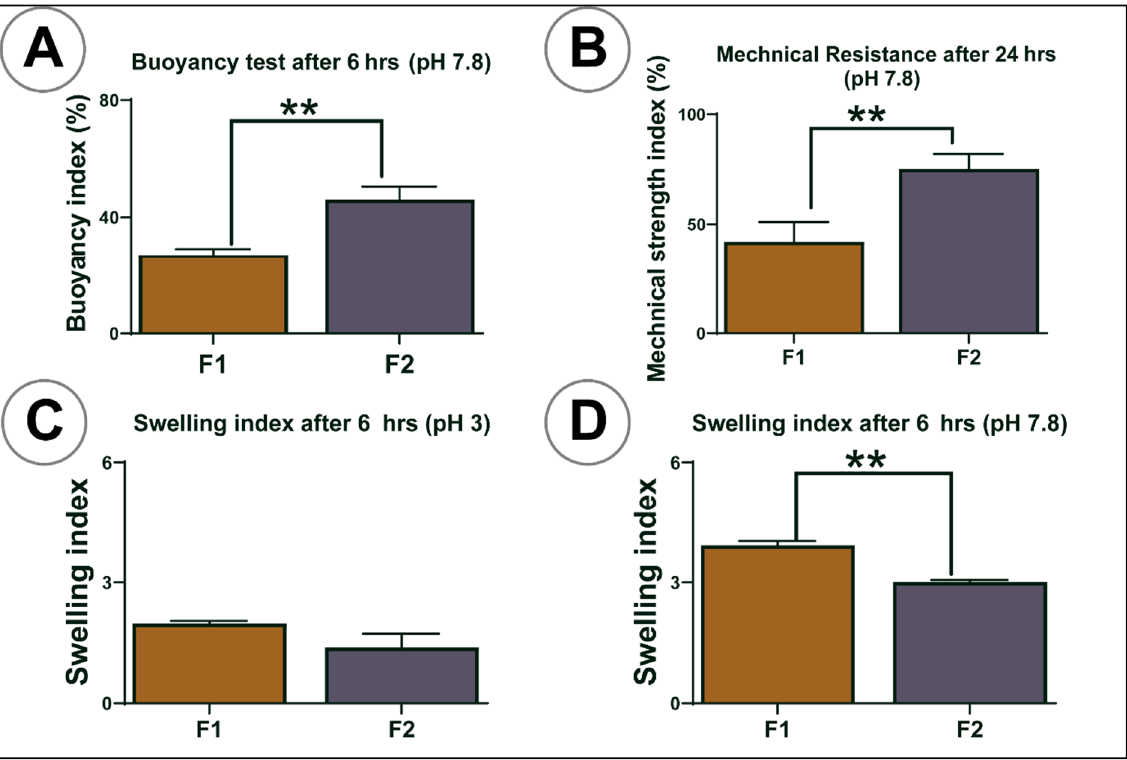
Figure 4. (A ) Buoyancy index at pH 7.8, ( B ) mechanical resistance at pH 7.8, ( C , D ) swelling index at pH 3 and ( D ). F1 = PB-SA microcapsules, F2 = PB-LCA-SA microcapsules. N = 3, mean ± SD. p < 0.01**.